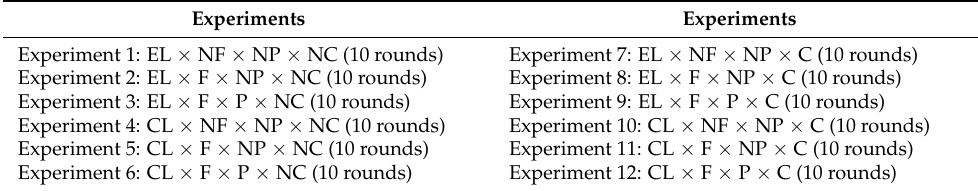
Table 2. Experimental